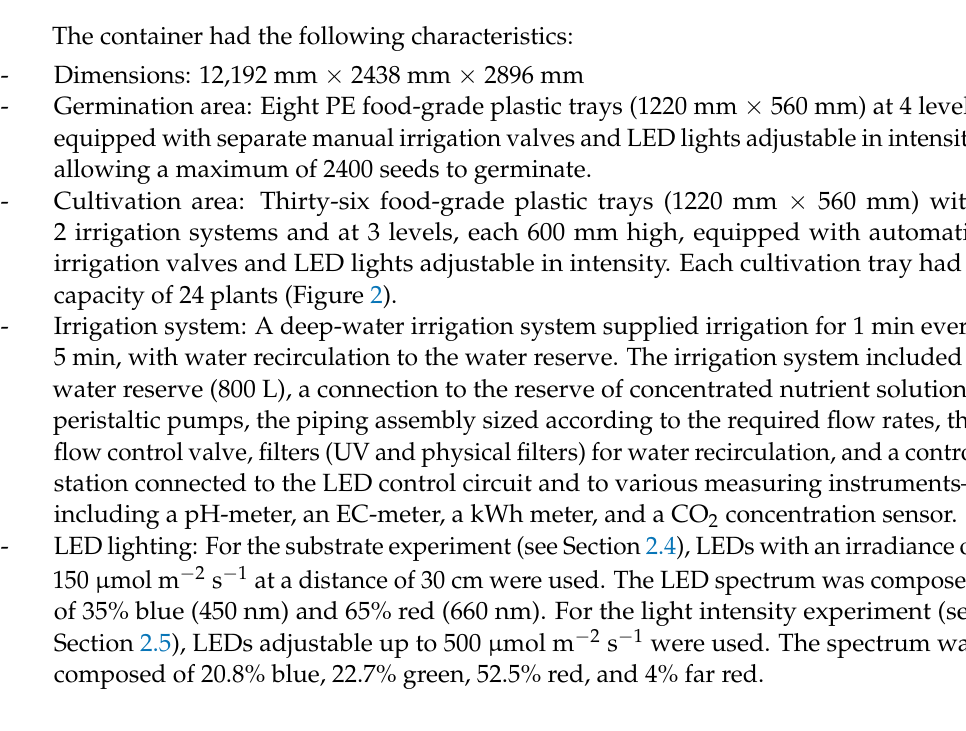
Figure 1. Modified vertical hydroponic shipping container.